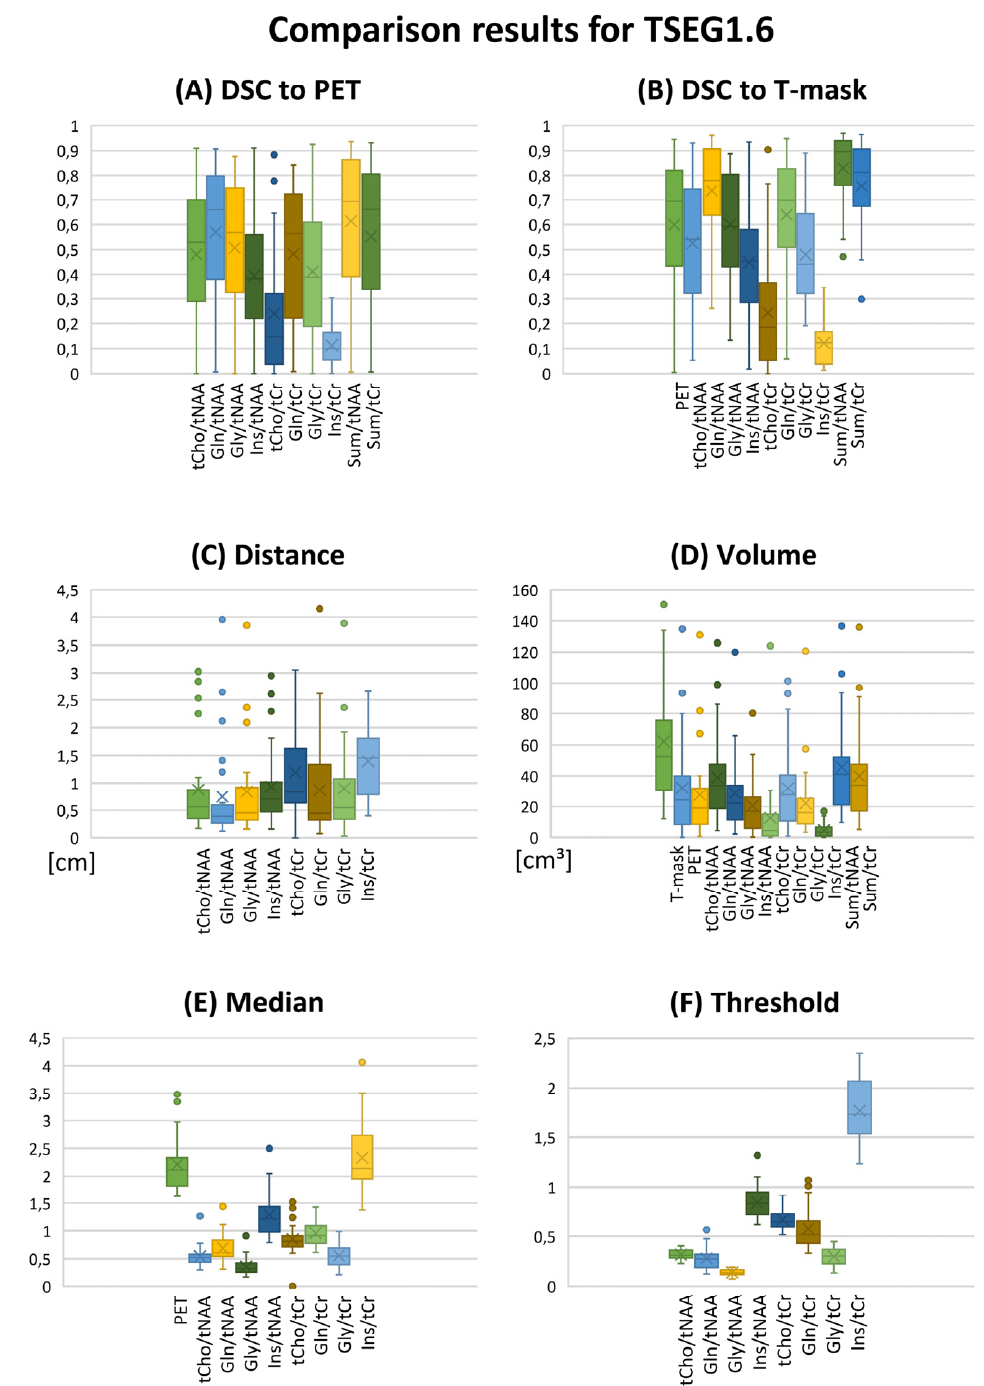
Figure 1. Overview of evaluation results as boxplots for the TSEG1.6 VOI definition. ( A , B ) DSCs for the comparison of MRSI ratios to PET and the T-segmentation. ( C ) CoI distance and ( D ) VOI volume. ( E ) Median ratios and ( F ) the calculated VOI thresholds. Gln/tNAA ratios show the best correspondence to PET. Key to the plot: Cross, mean; line, median; box, 2nd–3rd quartiles; whiskers, 1st and 4th quartiles.